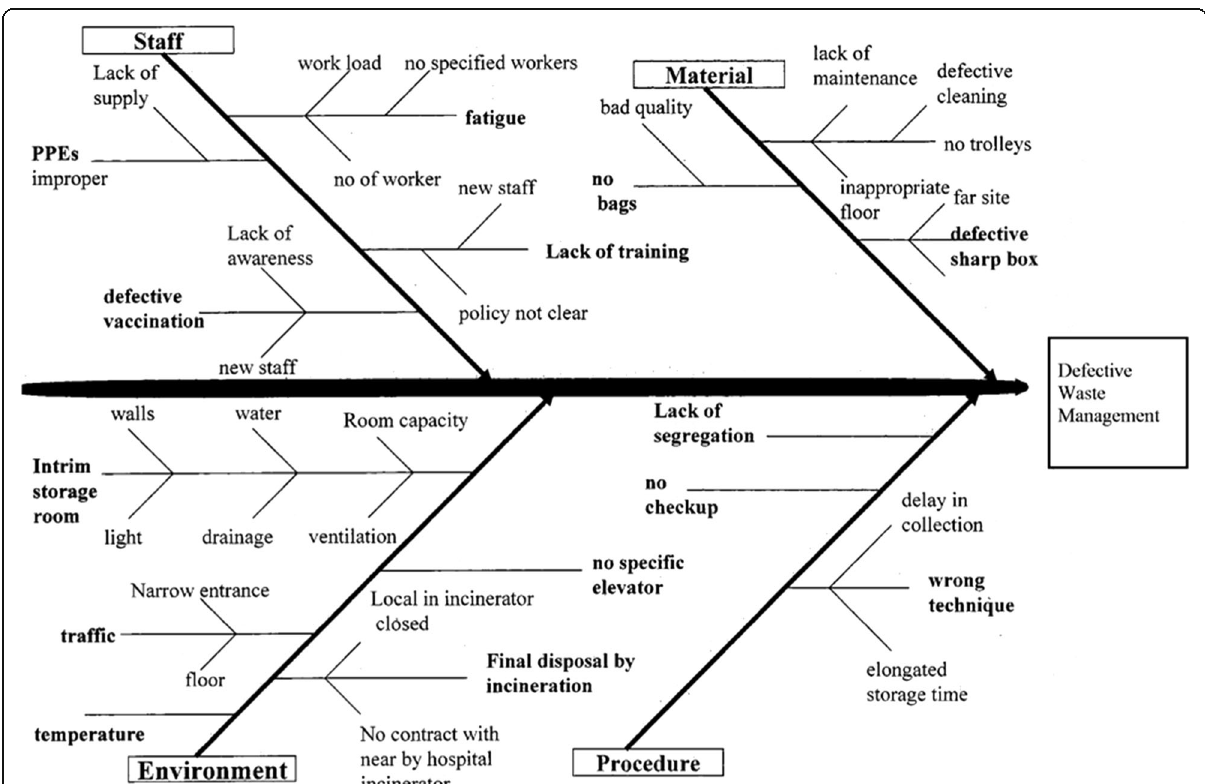
Fig. 1 Fishbone cause-effect diagram of defective waste management (original). A visualization tool for categorizing the potential causes of the problem (low adherence to waste management policy) in order to identify its root